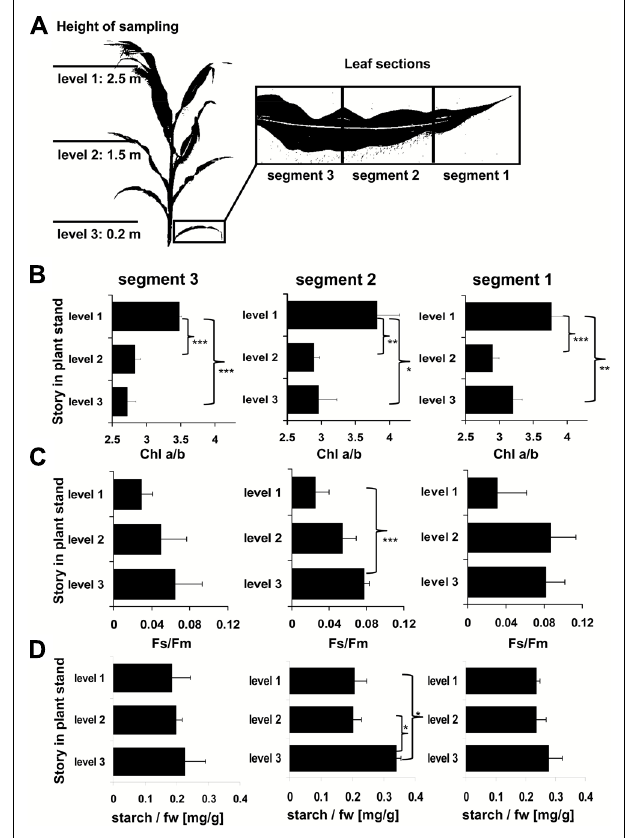
FIGURE 2 |Analysis of field grown maize. (A) Left panel displays height of leaf harvesting. Magnification on right defines the analyzed sections of the respective leaves.Three to five leaves of each level were harvested from different individuals distributed randomly over the field. (B) Chl a/b ratio, (C) Chl fluorescence, and (D) starch contents in field grown maize. Story of harvest is given on the left, respective leaf segment analyzed on top. Acclimation parameters Chl a/b and F s / F m were determined as described in Section “Materials and Methods.” Starch content is given relative to the fresh weight (fw). Data represent means from at least three independent biological replicates, standard deviation is given. A Student’s t -test was performed to test significance of differences (* P < 0.05, ** P < 0.01, *** P <